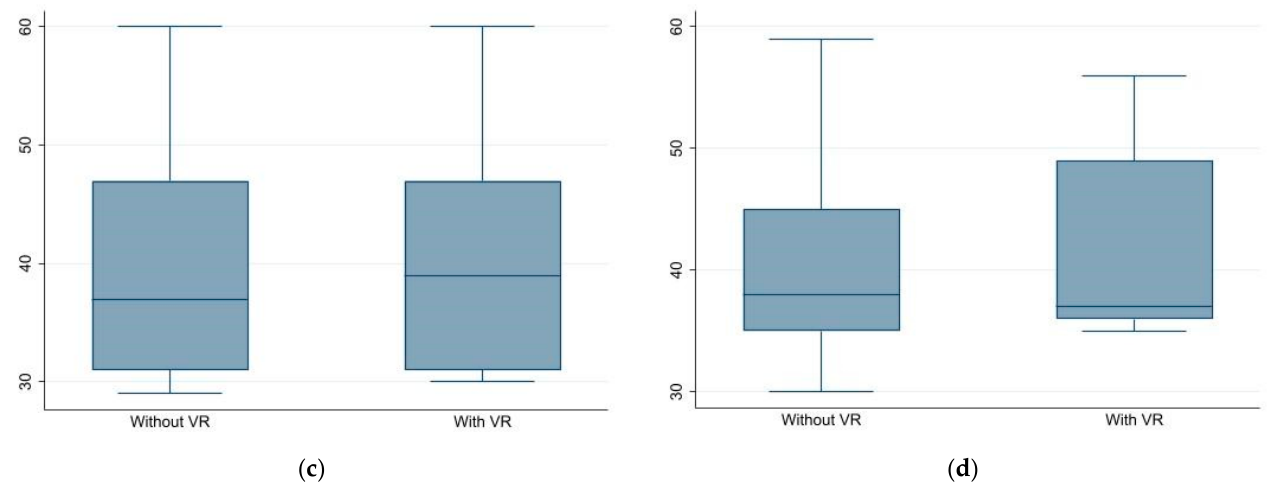
Figure 2. RCMAS-2 scale ( a ) physiological anxiety: without VR 37 (IQR 31–47); with VR 39 (IQR 31– 47); ( b ) social anxiety: without VR 38 (IQR 35–45); with VR 37 (IQR 36–49); ( c ) concern: without VR 38.5 (IQR 31–48); with VR 37.5 (IQR 32–45); ( d ) total results: without VR 36.5 (IQR 32–48); with VR 38.5 (IQR 32–48).